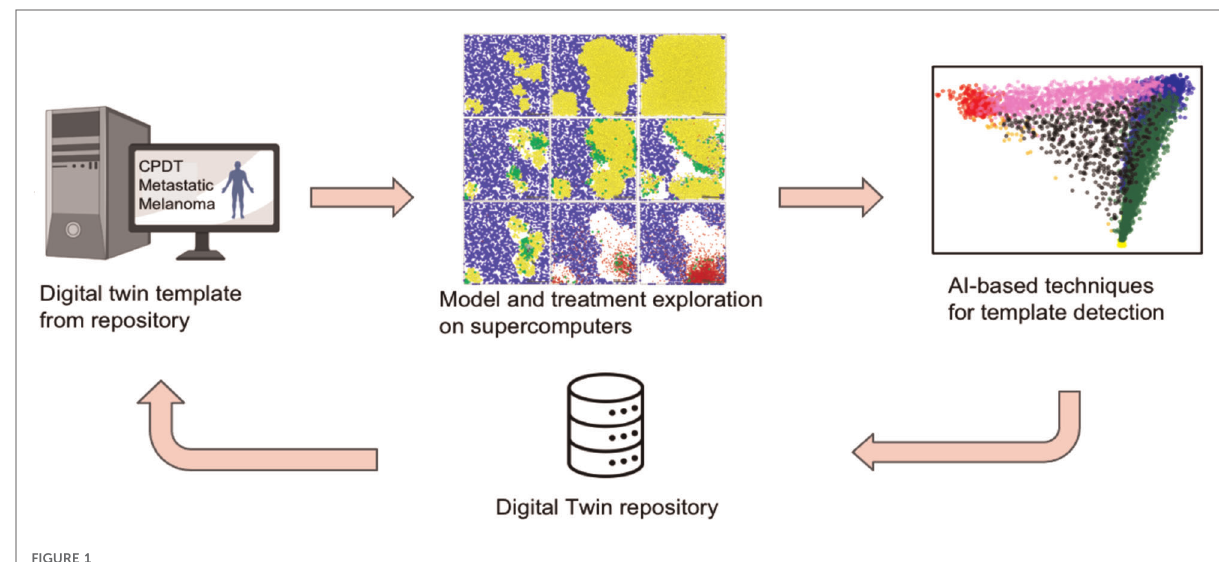
FIGURE 1 Overall approach to identify digital patient